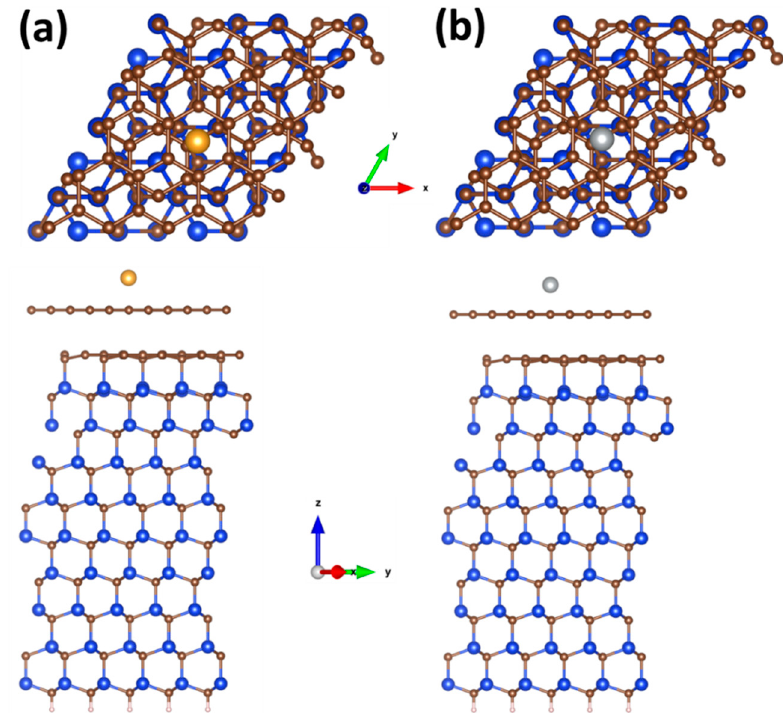
Figure 7. (Top view and side view) The optimized geometrical structures of gold ( a ) and silver ( b ) adatoms adsorbed onto monolayer epitaxial graphene. Blue, brown, and whitish balls designate Si, C, and H atoms, respectively. Yellow and gray colors correspond to gold and silver, respectively. This figure has been adapted with permission from [49]. Copyright 2021 WILEY-VCH Verlag GmbH & Co. KGaA, Weinheim, Germany.